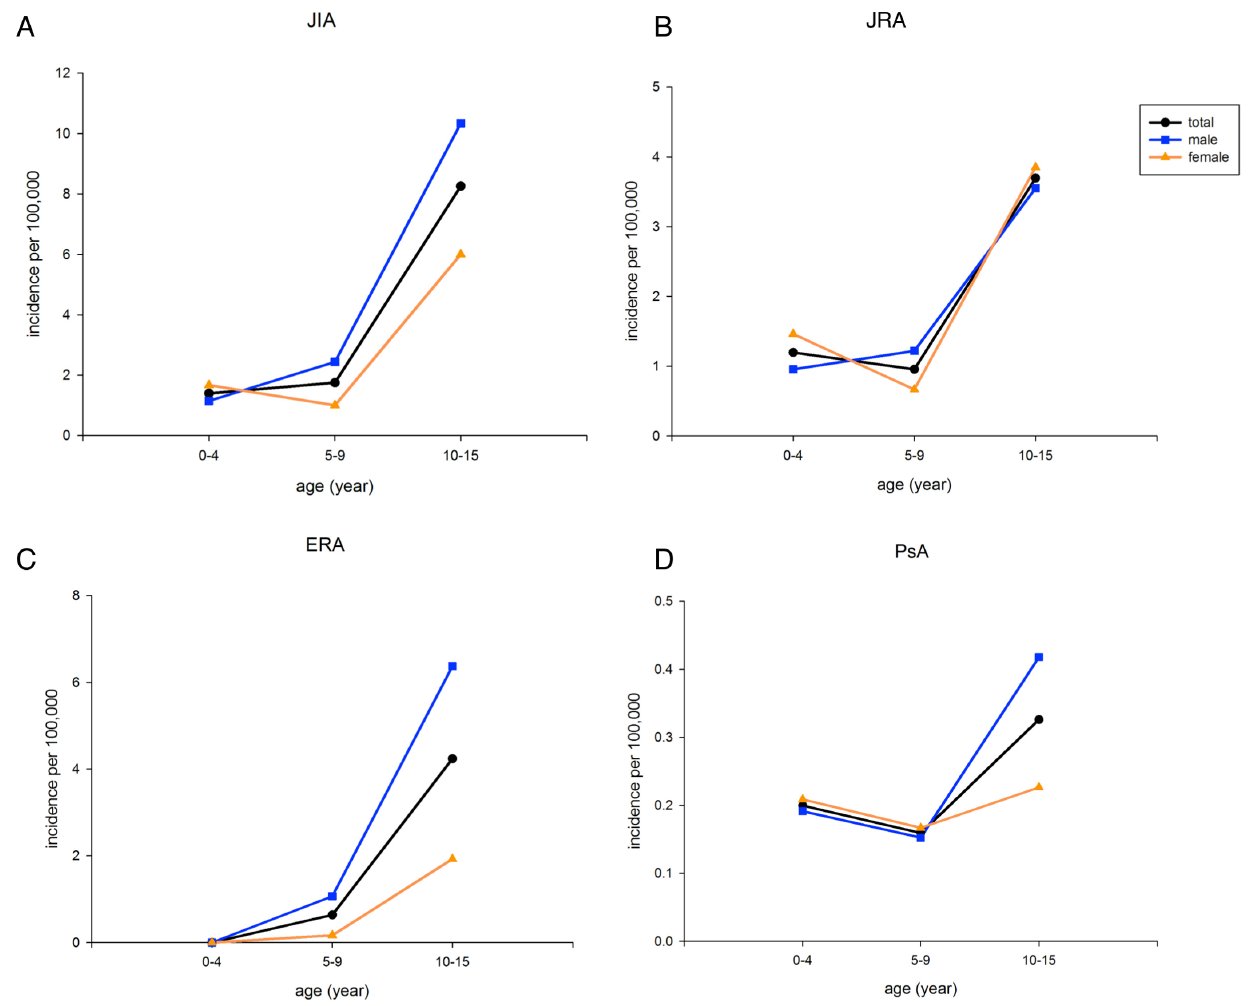
Figure 2. Age- and sex-specific incidence of JIA, JRA, ERA, and PsA in 2009. Incidence is higher in boys than in girls in patients with JIA aged 5–9 and 10–14 years old (male:female 2.4:1 and 1.8:1, respectively), ERA aged 5–9 and 10–15 years old (6.4:1 and 3.5:1, respectively), and PsA aged 10–15 years old (1.8:1). Incidence is higher in females in JIA patients aged 0–4 years old (0.7:1), JRA aged 0–4 and 10–15 years old (0.7:1 and 0.9:1, respectively), and PsA aged 0–9 years old (0.9:1).